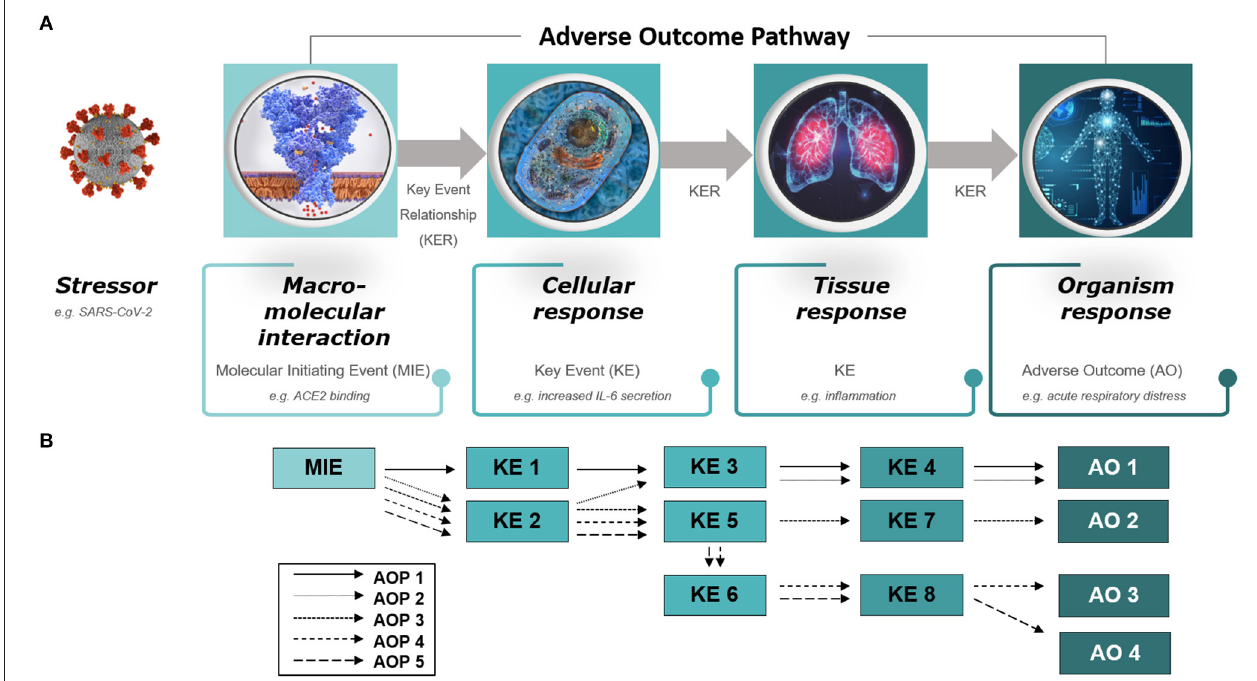
FIGURE 1 | Diagram of (A) an adverse outcome pathway (AOP) and (B) an AOP network. (A) An AOP starts with a molecular initiating event (MIE), followed by a series of key events (KEs) on different levels of biological organization (cellular, tissue, organ) and ends with an adverse outcome (AO) in an organism. The stressor is not part of the AOP itself. The diagram provides examples of an MIE, KEs, and an AO relevant to COVID-19, that is, ACE2 binding leading to IL-6 secretion, inflammation and acute respiratory distress. (B) AOP networks depict interrelated AOPs that share KEs, referred to as hub KEs, which, for example, may support identification of mechanisms central to diverse courses of action taken by COVID-19 in different patients. Please refer to reference ( 9) for a preliminary overview of a detailed AOP network for